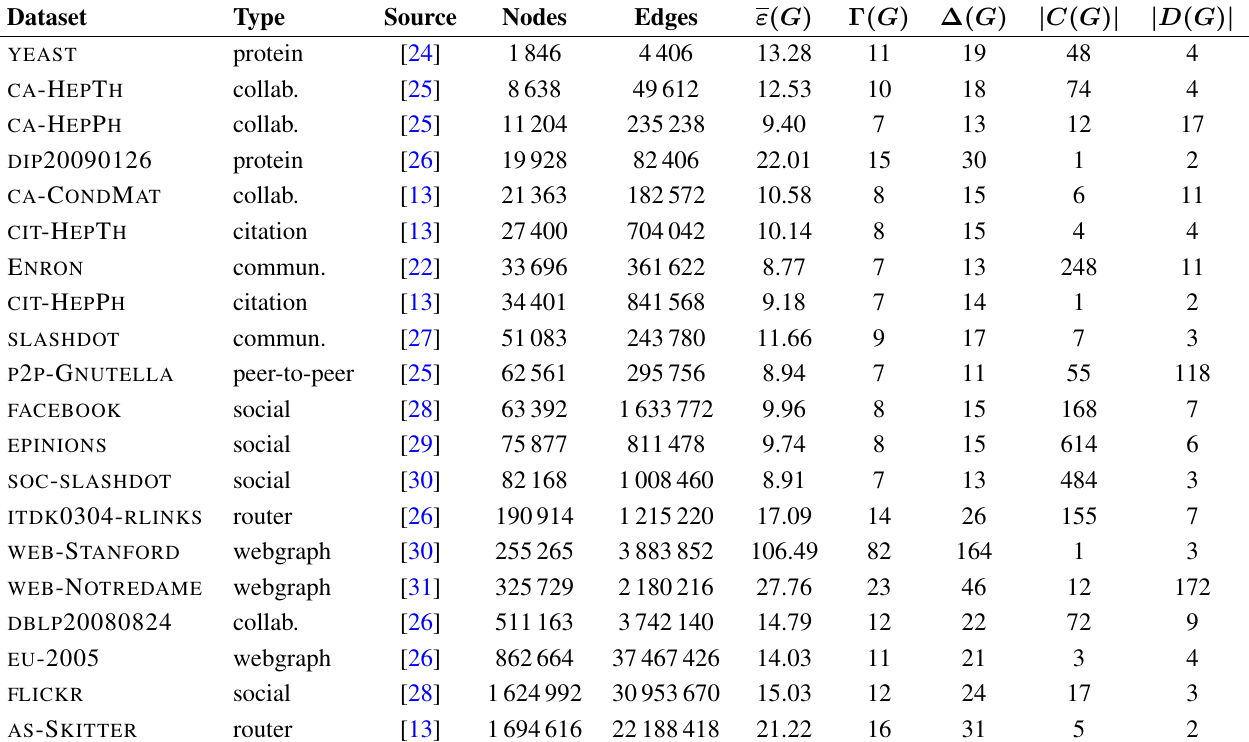
Table 1. Number of nodes, edges, average eccentricity, radius, diameter, center size and periphery size of our